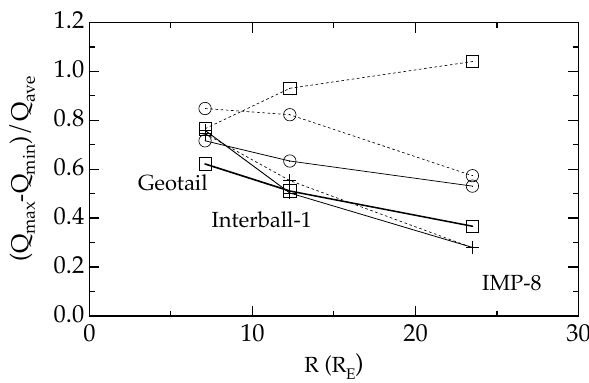
Fig. 8. Normalized values for the density (solid lines segments) and magnetic field strength (dashed line segments) variations as a function of distance along the IMF from the bow shock during three time intervals 16:00–16:40 (crosses), 16:50 to 17:35 (circles), and 17:40 to 18:15 (squares)